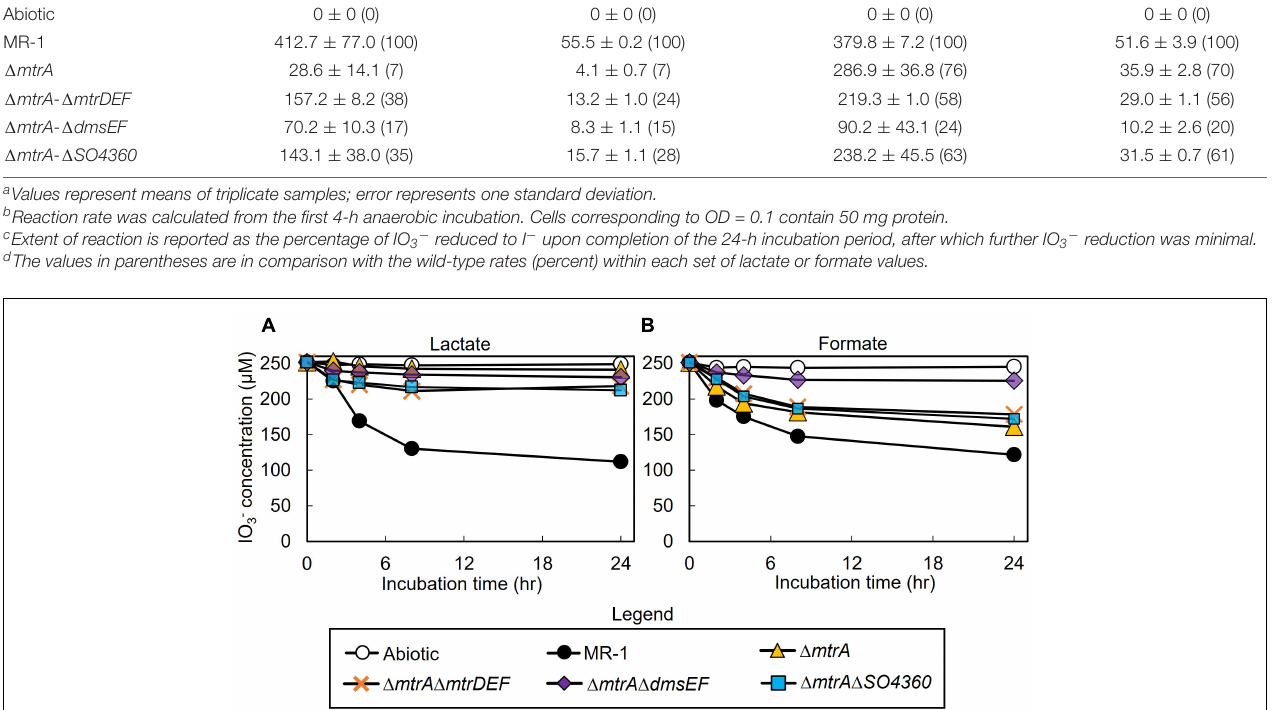
− reduction rate. Values are means of triplicate samples from 3